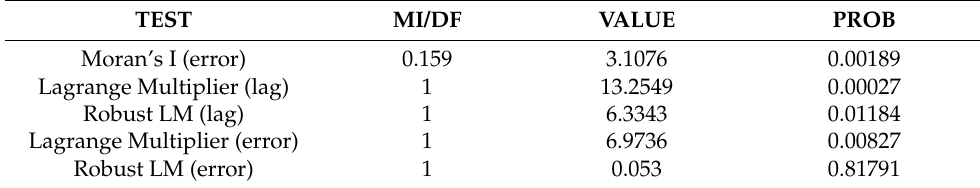
Table 4. Spatial correlation test.